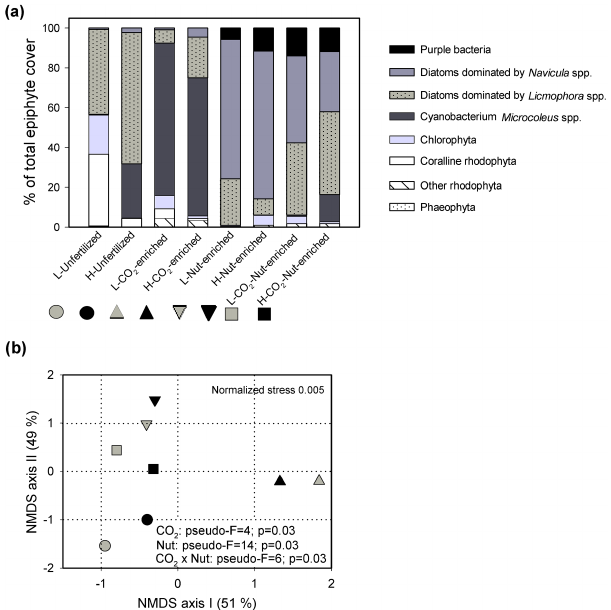
Figure 3. Responses of Zostera noltii epiphyte populations to the addition of CO 2 and nutrients: (a) Relative abundance of the main epiphyte taxa on plants exposed to experimental treatments; and (b) NMDS ordination of experimental treatments (see symbol leg- end in (a)) based on leaf epiphytes of plants from the low-nutrient (L; grey symbols) and high-nutrient meadow (H; black symbols). Pseudo- F statistics and p levels from two-way PERMANOVA test- ing are shown in the NMDS diagram for each fixed crossed factor (CO 2 ; Nut: nutrients) and their interaction (CO 2 ×